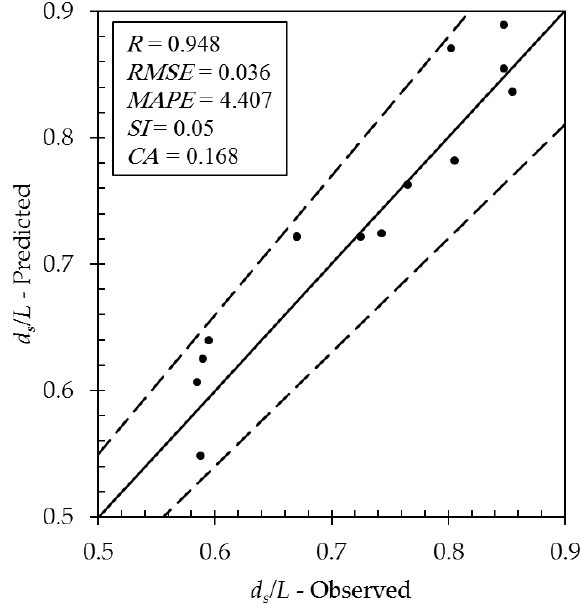
Figure 8. Scatter plot of developed ELM-based model for Ballio et al. [72] Figure 9. Scatter plot of developed ELM-based model for Ballio et al. [72] model.